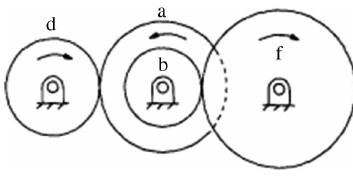
Figure 10: Gear Train Design [16].